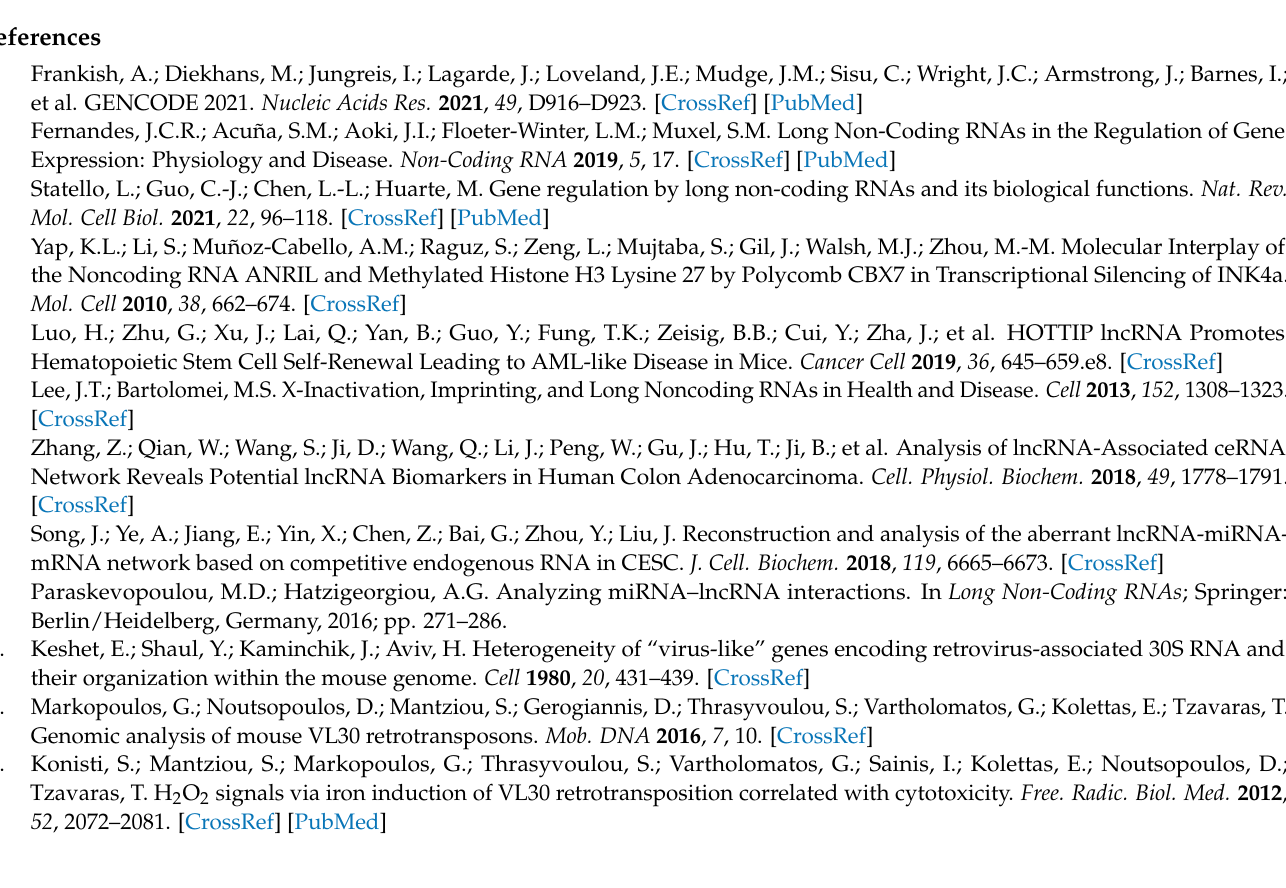
Figure S2: Distance of SEV-VL30s to mouse genes promoters. Figure S3: Distance of VL30 elements not associated with SEVs (non-SEV VL30s) to mouse genes promoters, following GREAT analysis. Figure S4: Enrichment for mammalian phenotypes in genes related to SEV-VL30s. Figure S5: Enrich- ment for mammalian phenotypes in genes related to to non-SEV VL30s. Table S1: Structural features of